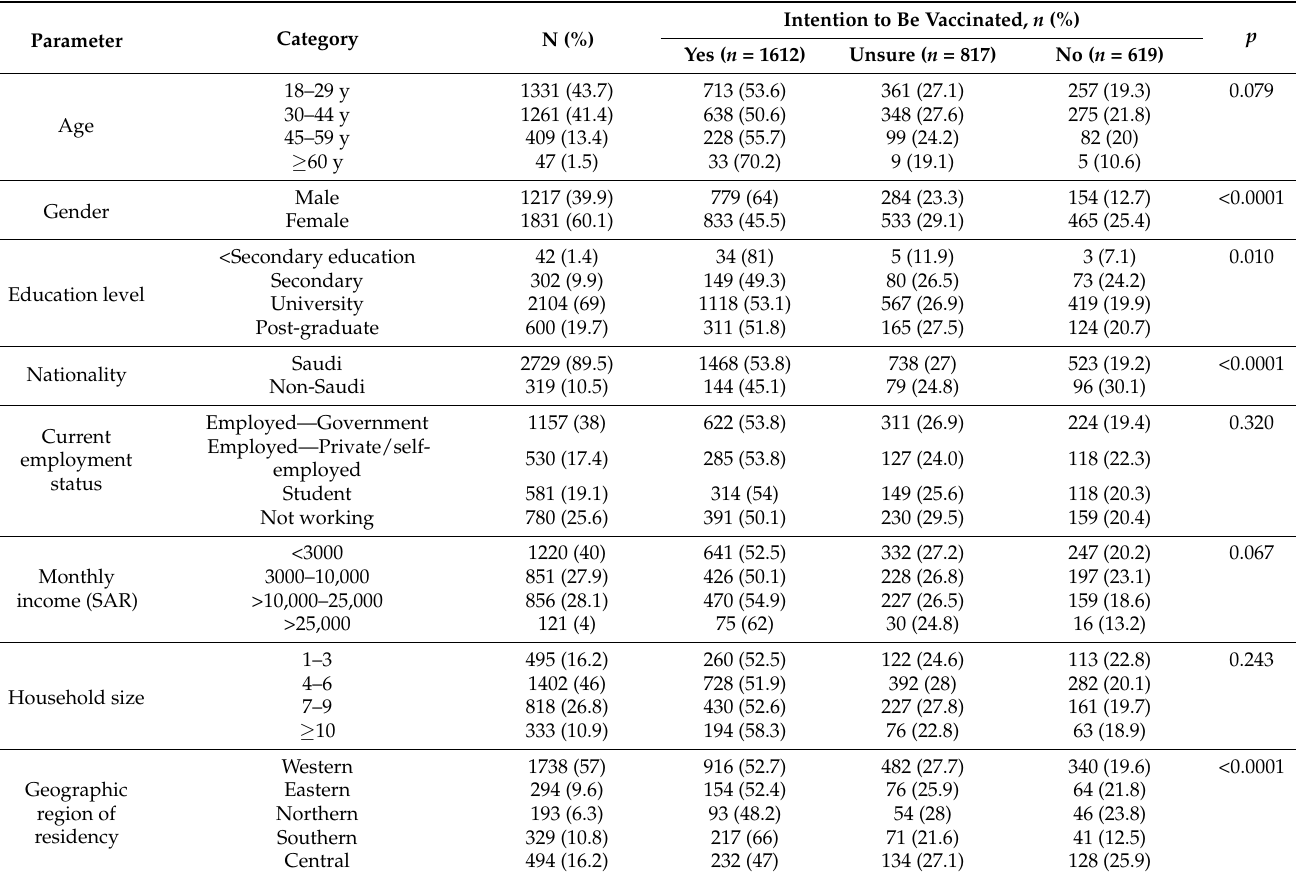
Table 1. Demographic characteristics of the participants and their distribution according to intention to be vaccinated ( n =